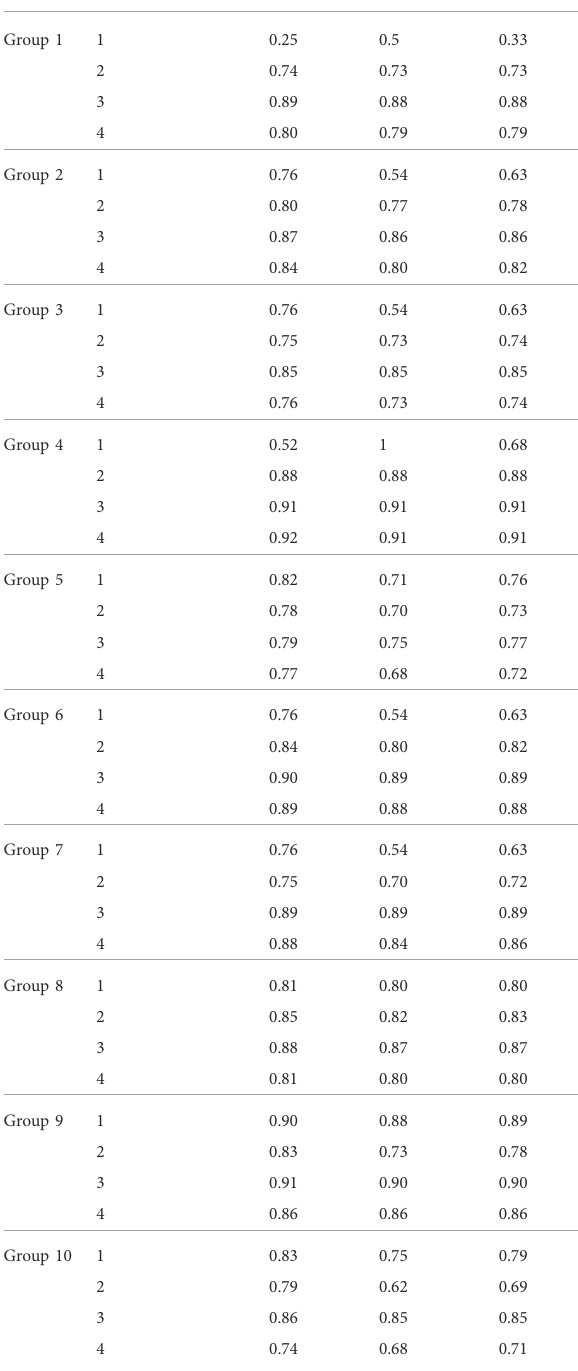
TABLE 3 Model accuracy in different targets on the panel sequencing data. Groups Average Targets Precision Sensitivity F1-score